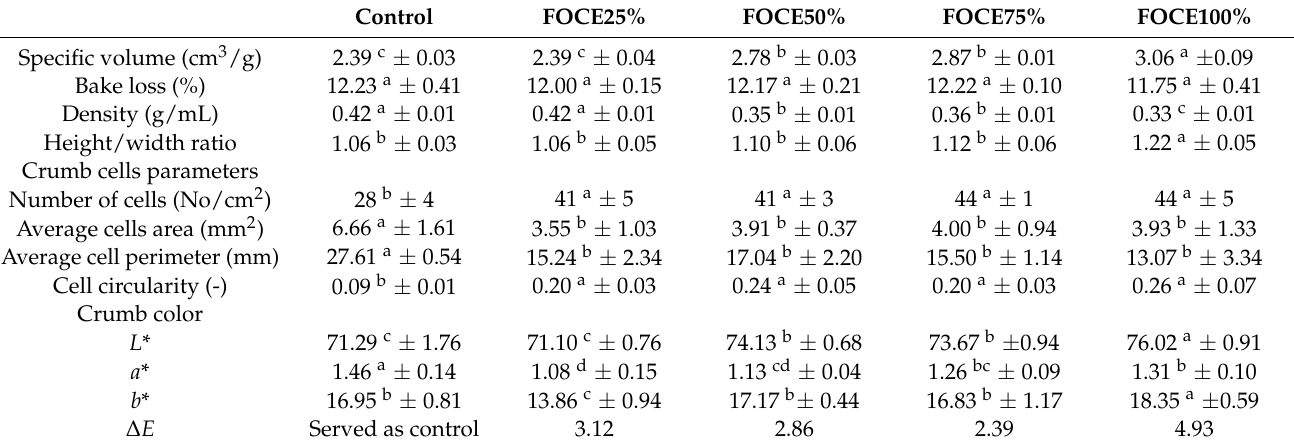
Table 2. The technological quality parameters of gluten-free breads with FOCE replacing